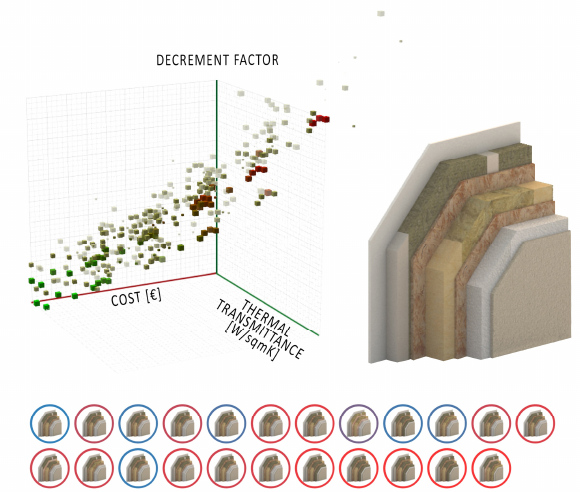
Figure 2. The multi-parametric wall optimization allows the selection of different wall configurations.